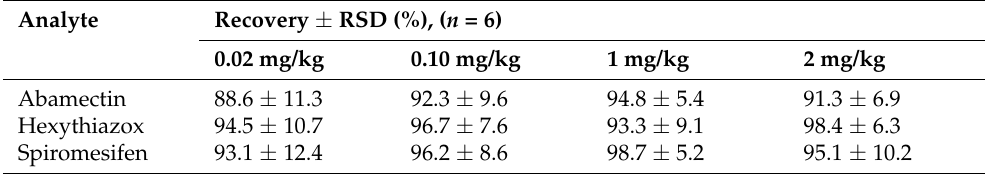
Table 3. Recovery and RSD of the three